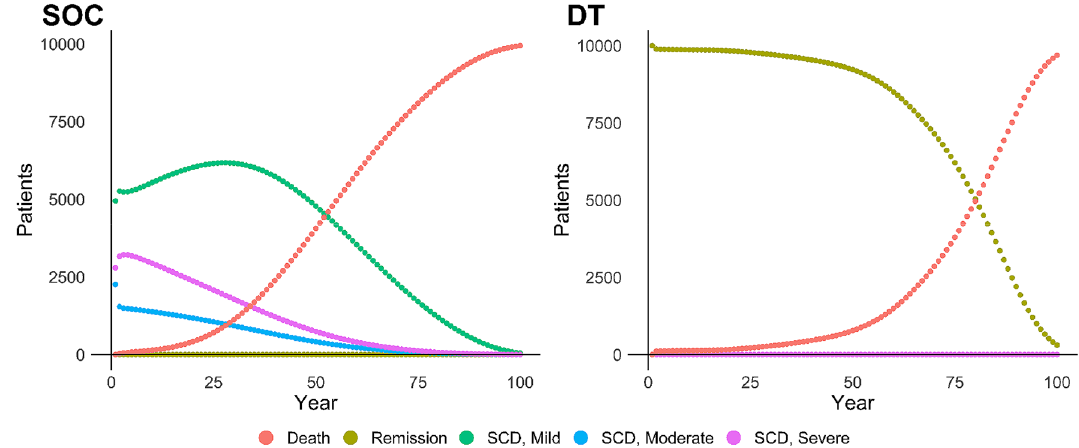
Figure 2. Markov trace for SOC and DT arms (N = 10,000 theoretical patients). SOC standard of care, DT durable therapy, SCD sickle cell disease.